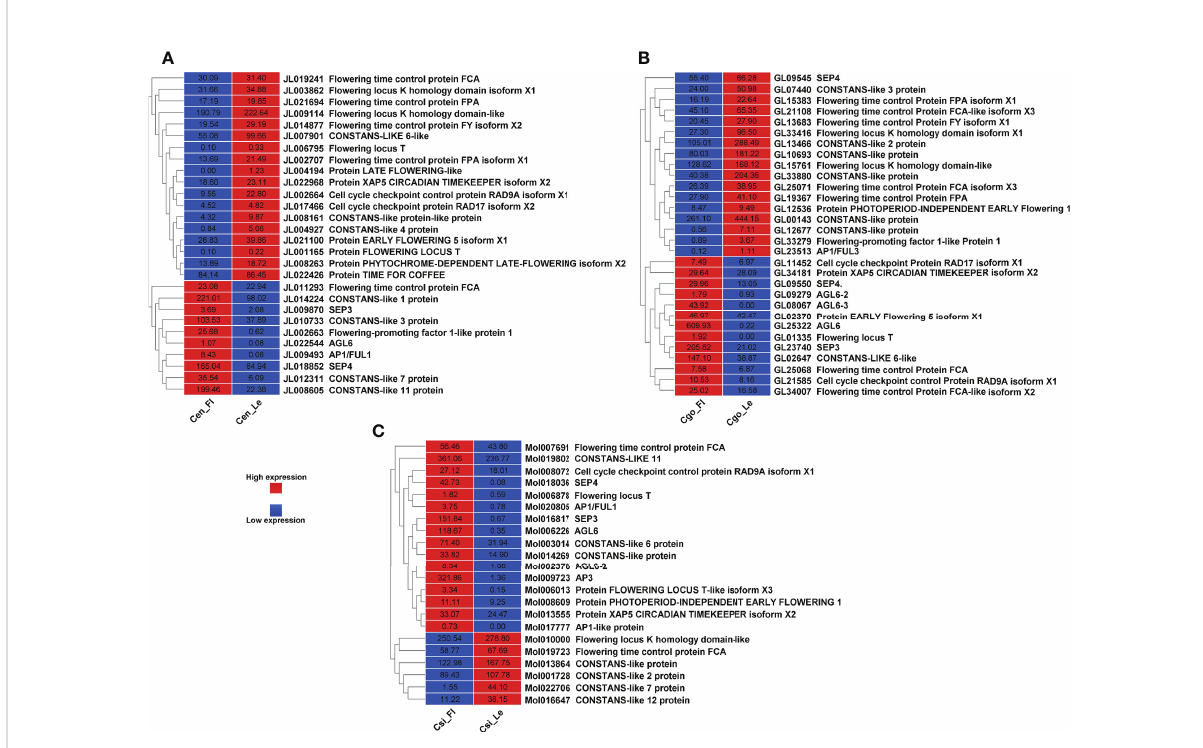
FIGURE 5 Flowering related genes for C. ensifolium (A) , C. goeringii (B) and C. sinense (C)